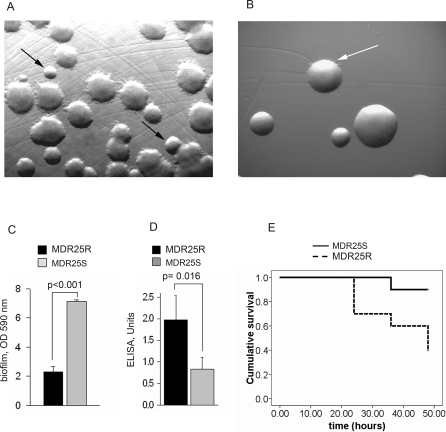
Colony Morphology Variation in MDR25 Correlates with Production of Outer Surface-Exposed PstS and Virulence(A) The appearance of smooth edged colonies as shown by black arrows in MDR25 grown on PIA, Gm 50 μg/ml.(B) A single smooth colony was isolated, cultivated in PB, Gm 50 μg/ml, and plated on PIA, Gm 50 μg/ml. The appearance of rough edged colony is shown by the white arrow.(C) Biofilm production by rough (MDR25R) and smooth (MDR25S) strains grown in PB, Gm 50 μg/ml.(D) Expression of outer surface PstS in MDR25R and MDR25S grown on PIA, Gm 50 μg/ml.(E) Kaplan-Meier survival curves of mice intestinally inoculated with MDR25S or MDR25R demonstrating attenuated killing effect of MDR25S. n = 10/group, p = 0.021.